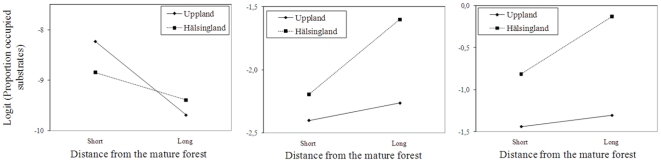
Interactions between explanatory variables.Plots for effects of the interaction between region and distance from the mature forest (“short” = transect 1, and “long” = transect 8) on occupancy of a) forest-interior species, b) open-habitat species, and c) C. botrytes (open-habitat lichen). The plots are based on parameter estimates in generalized linear mixed models for the two variables and the intercept of the final model (following http://www.jeremydawson.co.uk/slopes.htm, accessed september 2010).